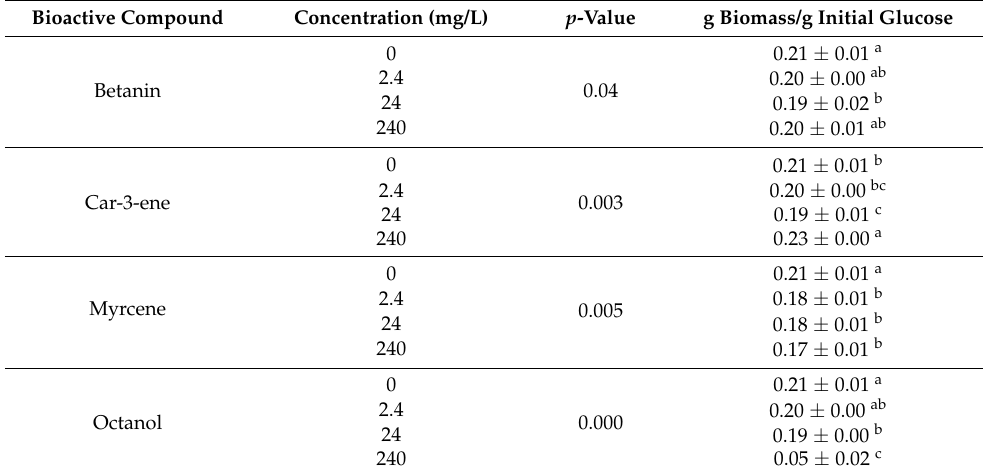
Different letters show the significance of difference within each bioactive compound